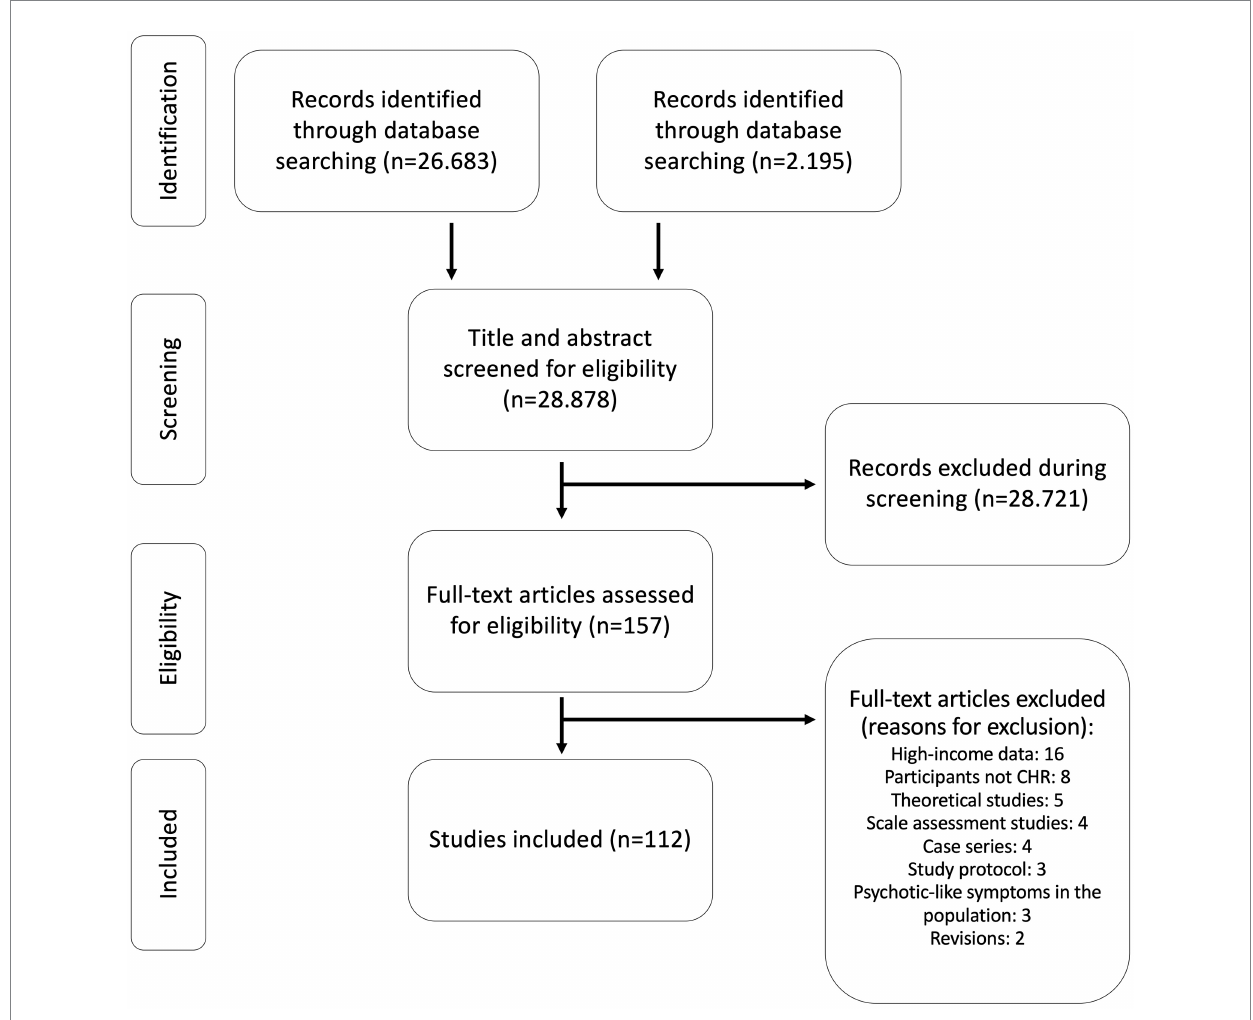
FIGURE 1 PRISMA flow chart of included